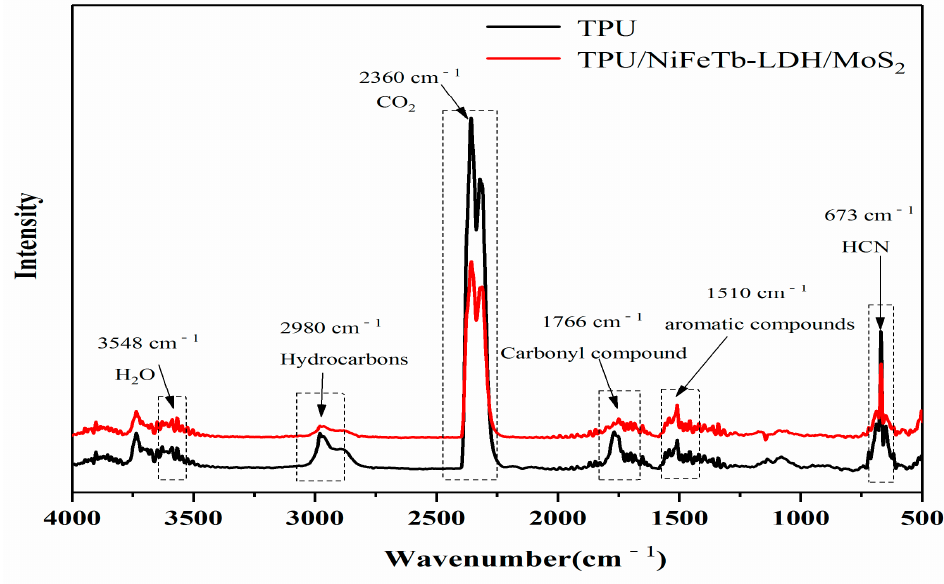
Figure 13. FTIR spectra of TPU and TPU/NiFeTb-LDH/MoS 2 pyrolysis products at maximum decomposition rate.